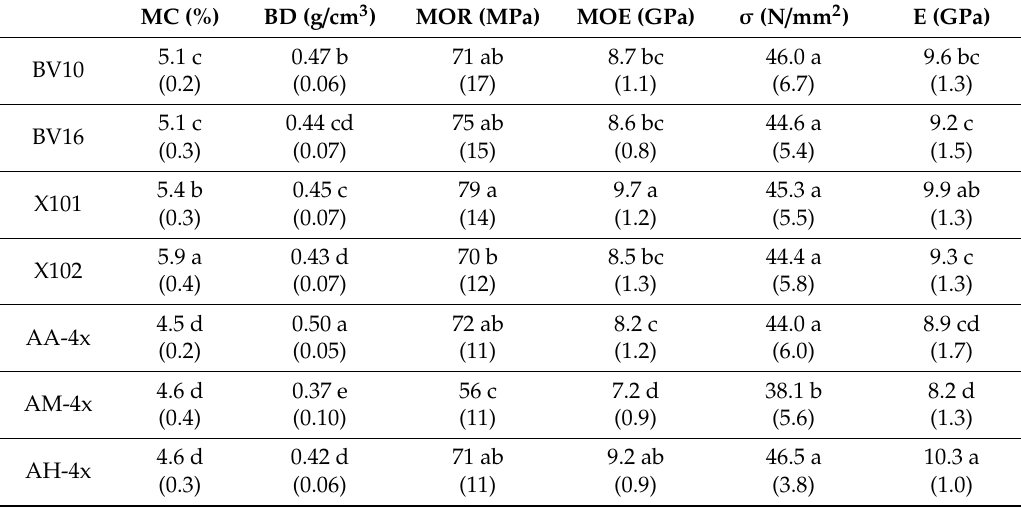
Table 2. Wood properties and ANOVA results in di ff erent clones.